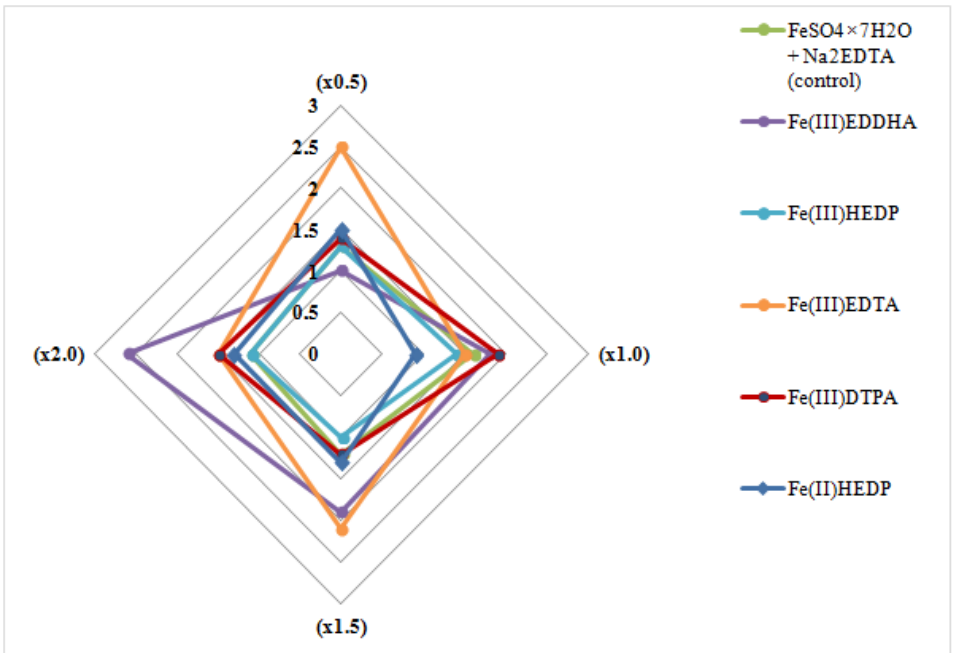
Figure 1. Shoot multiplication factor of blue honeysuckle “Lulia” ( Lonicera caerulea var. kamtschatica Sevast.) when applying different sources of iron in 4 concentrations: reduced (×0.5), standard (×1.0), increased (×1.5), and doubled (×2.0).